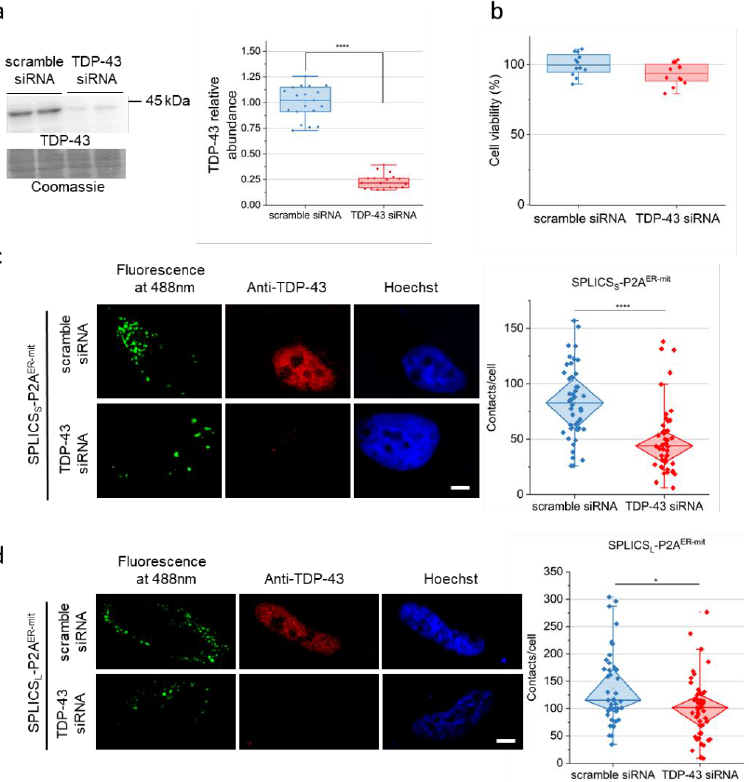
Figure 1. siRNA knock-down of TDP-43 does not influence cell viability but affects ER–mitochondria tethering in HeLa cells. ( a ) WB analysis of TDP-43 abundance in either TDP-43-silenced or con- trol (scramble) HeLa cells. On the left, a representative WB and the corresponding Coomassie blue staining are shown. The box plot on the right reports the densitometric analysis of TDP-43 immunoreactive band intensity in the two cell populations. n = 18. ( b ) HeLa cell viability after scrambled or TDP-43 siRNA treatment, determined by the MTS assay. ( c , d ) MERCs density was evaluated by confocal microscopy on TDP-43-silenced and control HeLa cells using plasmids coding for either (SPLICS) ER-mit -short(S)-P2A ( panel c ) or for SPLICS ER-mit -long(L)-P2A ( panel d ) probes (green signal). Cells were also stained with an anti-TDP-43 antibody (red signal) and the nuclear marker Hoechst (blue signal). In panel c and d, the white scale bar correspond to 5 µ m. In the right part of each panel, the diamond box plot reports the quantification of the indicated SPLICS S/L -P2A dots, as described in Materials and Methods. In ( c ), n = 84 cells for scrambled siRNA and 86 cells for TDP-43 siRNA; in ( d ) n = 43 cells for scrambled siRNA, and 57 cells for TDP-43 siRNA. n.s., not significant, * p < 0.05, **** p < 0.0001 (Mann–Whitney U